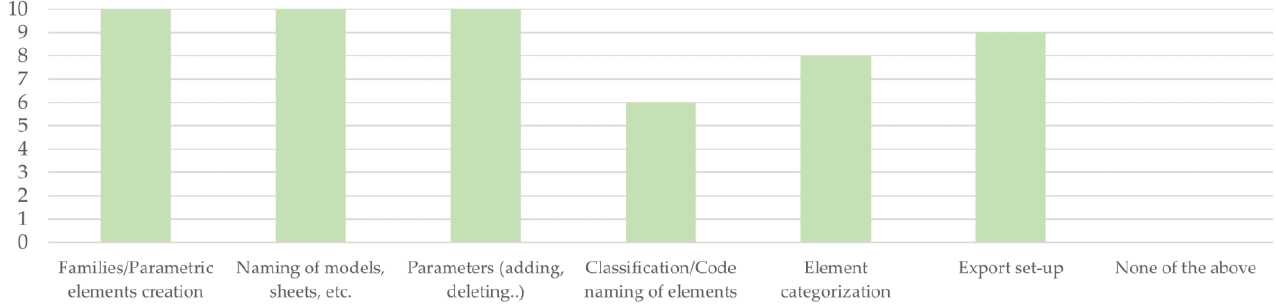
Figure 7. Responses to the question: “Which of the following tasks have been done by your team in the project?—part Templates preparation in BIM design software”.